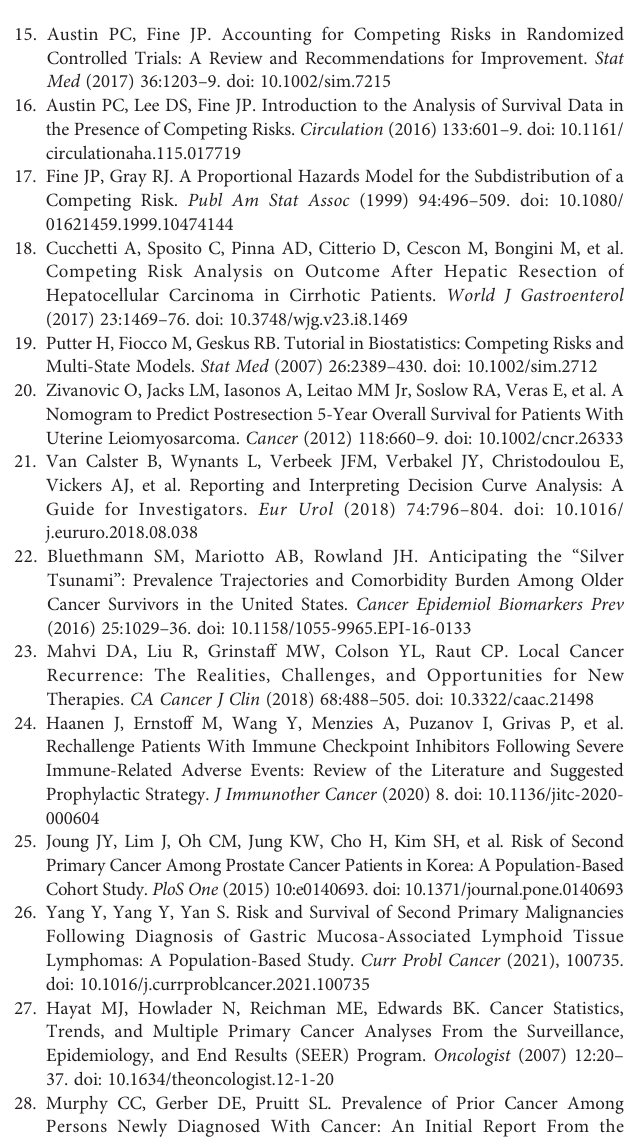
Supplementary Figure 1 | Work fl ow of patient selection from the Surveillance, Epidemiology, and End Results (SEER) research database. Supplementary Figure 2 | Top 10 most common sites of developing a secondary primary malignancy in patients with hepatocellular